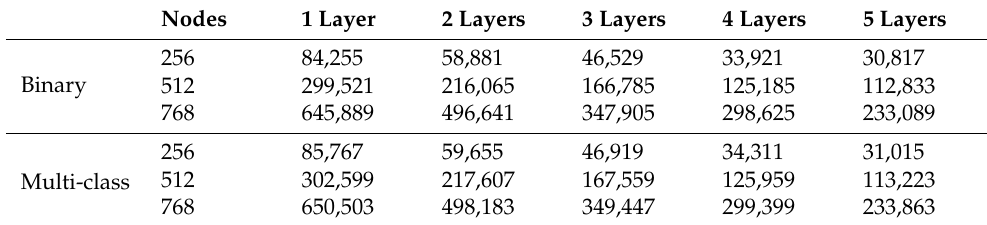
Table 12. The number of parameters of the RNN model.